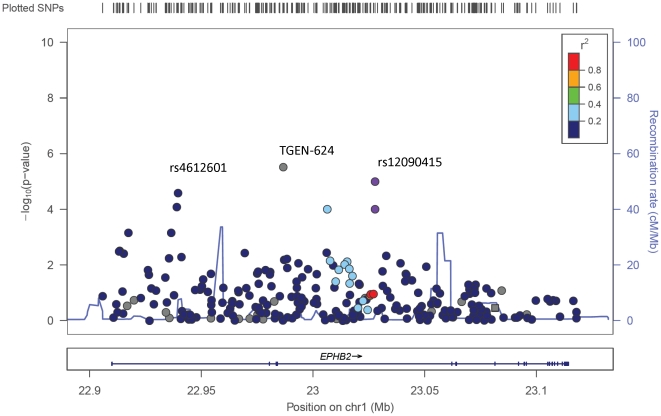
Plot of empirical -log10(p-values) from tests of association between SNPs across EphB2 gene region and prostate cancer risk in African Americans.Plot includes a display of linkage disequilibrium (r2) based on HapMap Yoruba (YOR) data and positions of SNPs along chromosome 1. SNPs shown in gray were not in HapMap. Recombination rates are depicted by the blue line within the plot. Association analysis P-values were adjusted for age and global west African ancestry and visualized using LocusZoom (http://csg.sph.umich.edu/locuszoom/).